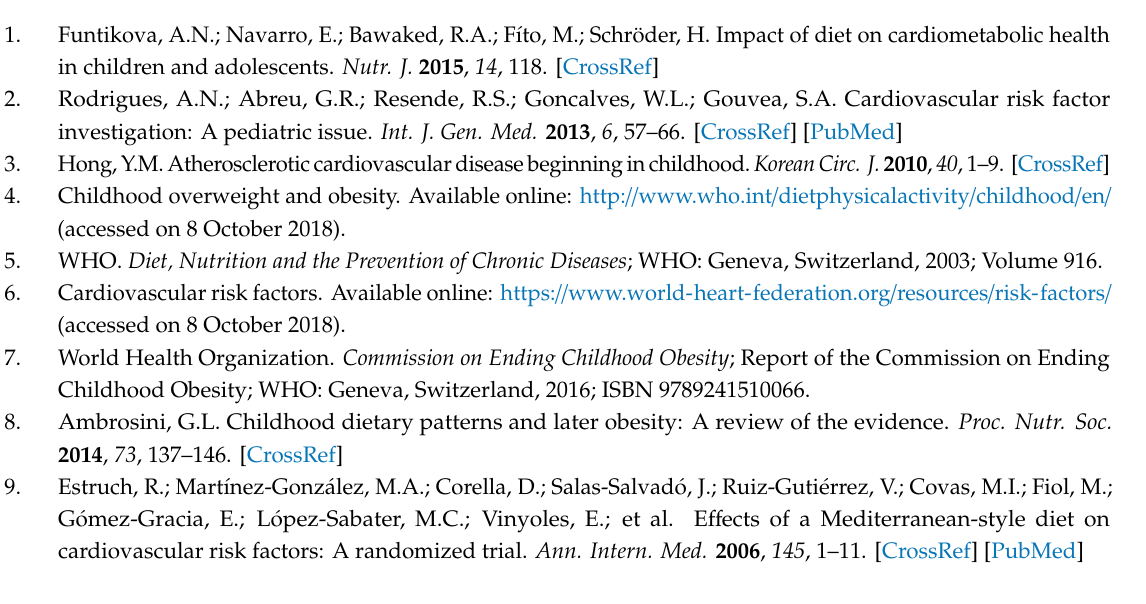
Table S4: Correlation between dietary pattern and anthropometric, hemodynamic, and gluco-lipid parameters, Supplementary Table S5: Correlation between physical activity, expressed in PAQC score and MET-min / week, and anthropometric, hemodynamic and gluco-lipid parameters, Supplementary Table S6: Di ff erence of anthropometric, hemodynamic, and gluco-lipidic parameters among categories of “low”, “medium”, and “high” adherence to moderate-vigorous physical activity, Supplementary Table S7 (a–f): Multivariate models including dietary intake and physical activity in relation to anthropometric, hemodynamic and gluco-lipidic